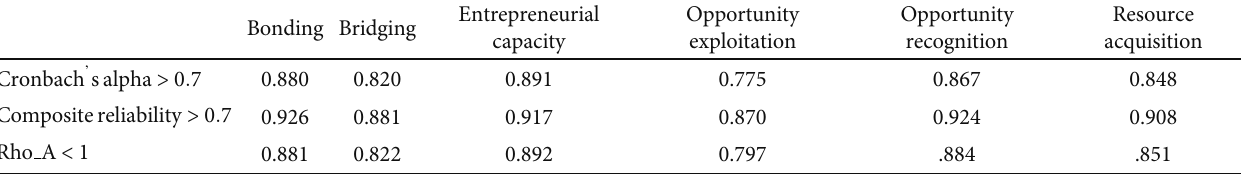
Figure 1: Research model (source: developed by the authors). Table 1: Internal reliability and